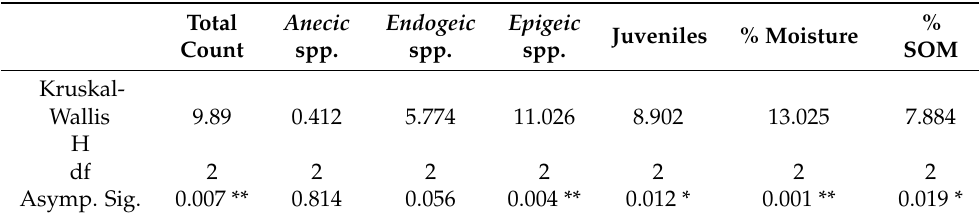
Table 2. Kruskal–Wallis test statistical output for three treatments (* p (Asymp. sig) ≤ 0.05; ** p (Asymp. sig) ≤